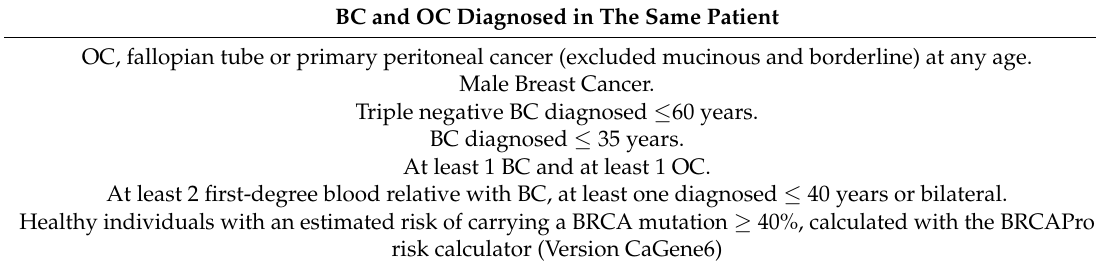
Table 2. The Modena Criteria (AIOM Guidelines 2018).